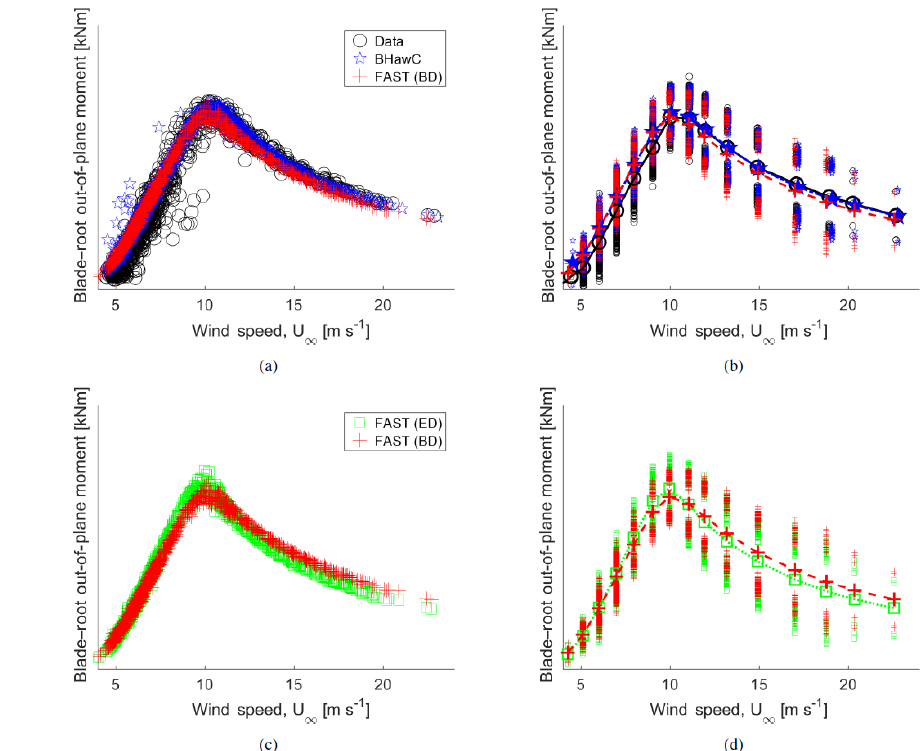
Figure 7. Blade-root out-of-rotor-plane bending moments. (a) Individual 10min averages from experimental data, BHawC, and FAST (BD). (b) Binned averages of data in (a) are denoted by points connected by lines; the scatter above and below these data denotes plus or minus 1 standard deviation, respectively, of the individual 10min data sets in that bin. (c) Individual 10min averages from FAST (BD) and FAST (ED). (d) Binned averages of data in (c) are denoted by the points connected by lines; the scatter above and below these data denotes plus or minus 1 standard deviation, respectively, of the individual 10min data sets in that